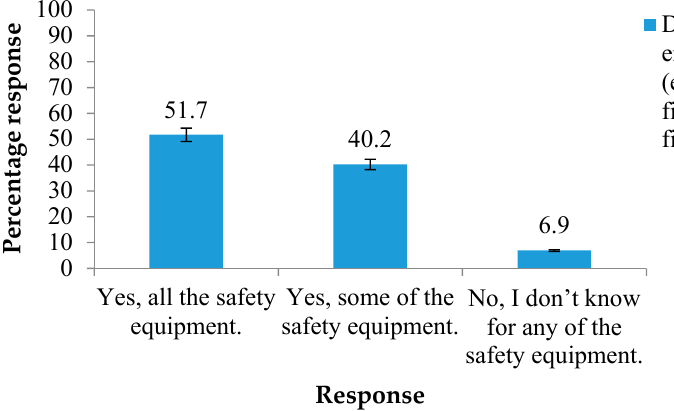
Figure 5. Percentage distribution of students’ response for the question on Emergency Equipment and